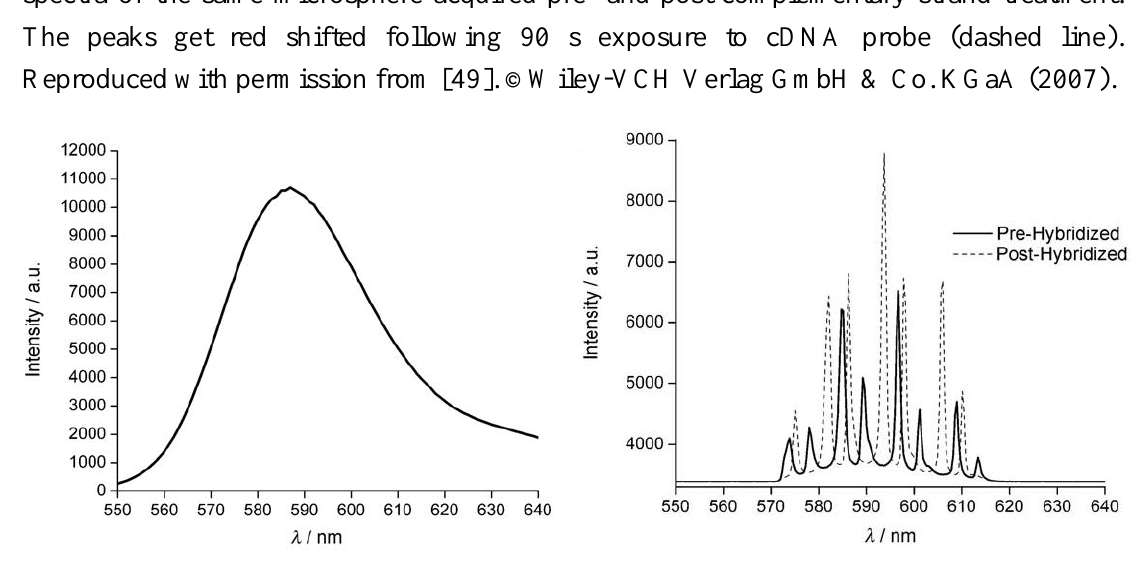
Bacillus atrophaeus subsp. Golbigii (B. golbigii). The authors used two different parameters, i.e. , the apparent refractive index and the calculated mean TE-TM mode spacing, for successful detection of the spores. Figure 16. Fluorescent spectrum of the TMR-dyed microsphere. Right: WGM emission spectra of the same microsphere acquired pre- and post-complementary strand treatment. The peaks get red shifted following 90 s exposure to cDNA probe (dashed